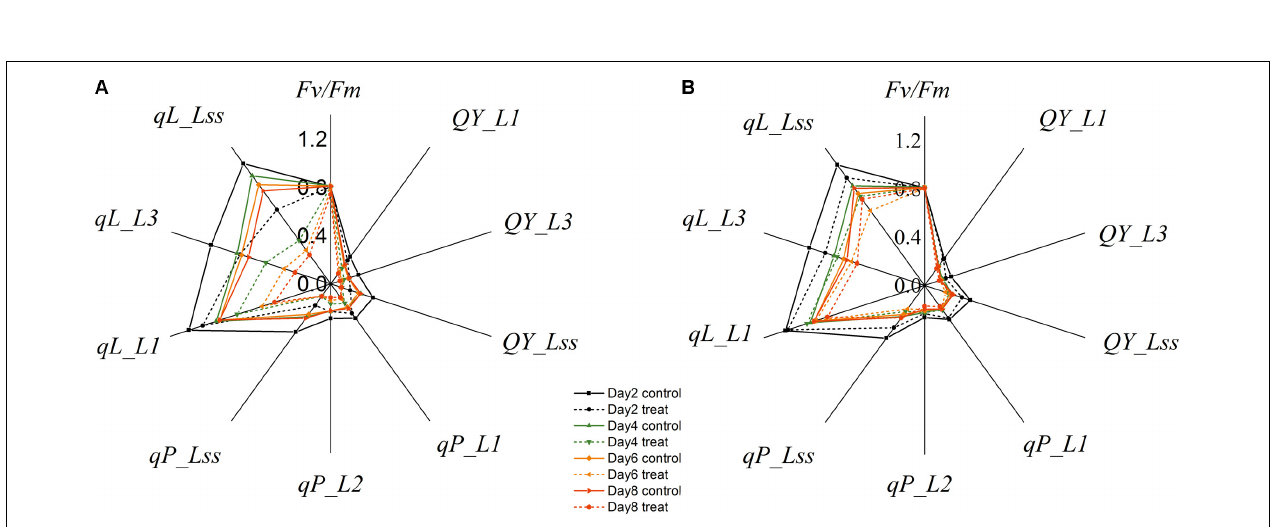
FIGURE 9 | Relative changes in mean values of selected chlorophyll fluorescence parameters in WT (A) and TG (B) maize plants treated with glyphosate.